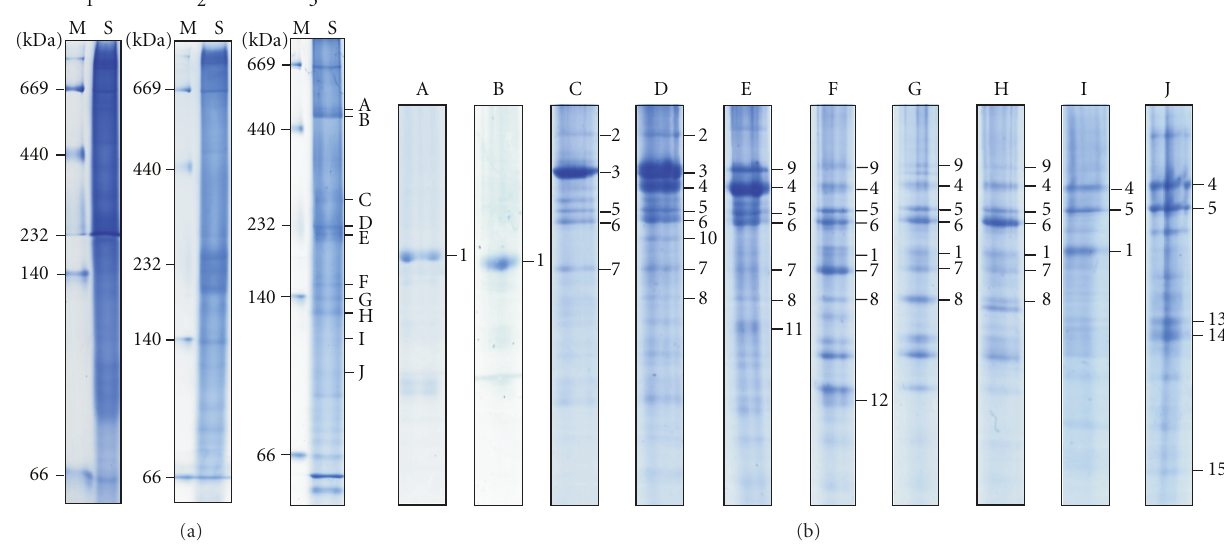
Figure 1: 6% (1), 5–10% (2), and 5–12% (3) separating gels were used to separate the protein complexes from SW1990 cell lysate. M: GE Healthcare HMW-Native protein markers; S: cell lysate of SW1990 (a). SDS-PAGE of ten protein complexes labeled with A–J from 5–12% CN-PAGE. At least two-band combination of each complex was used to run SDS-PAGE (b). Table 1: Identification results of HSP-associated protein